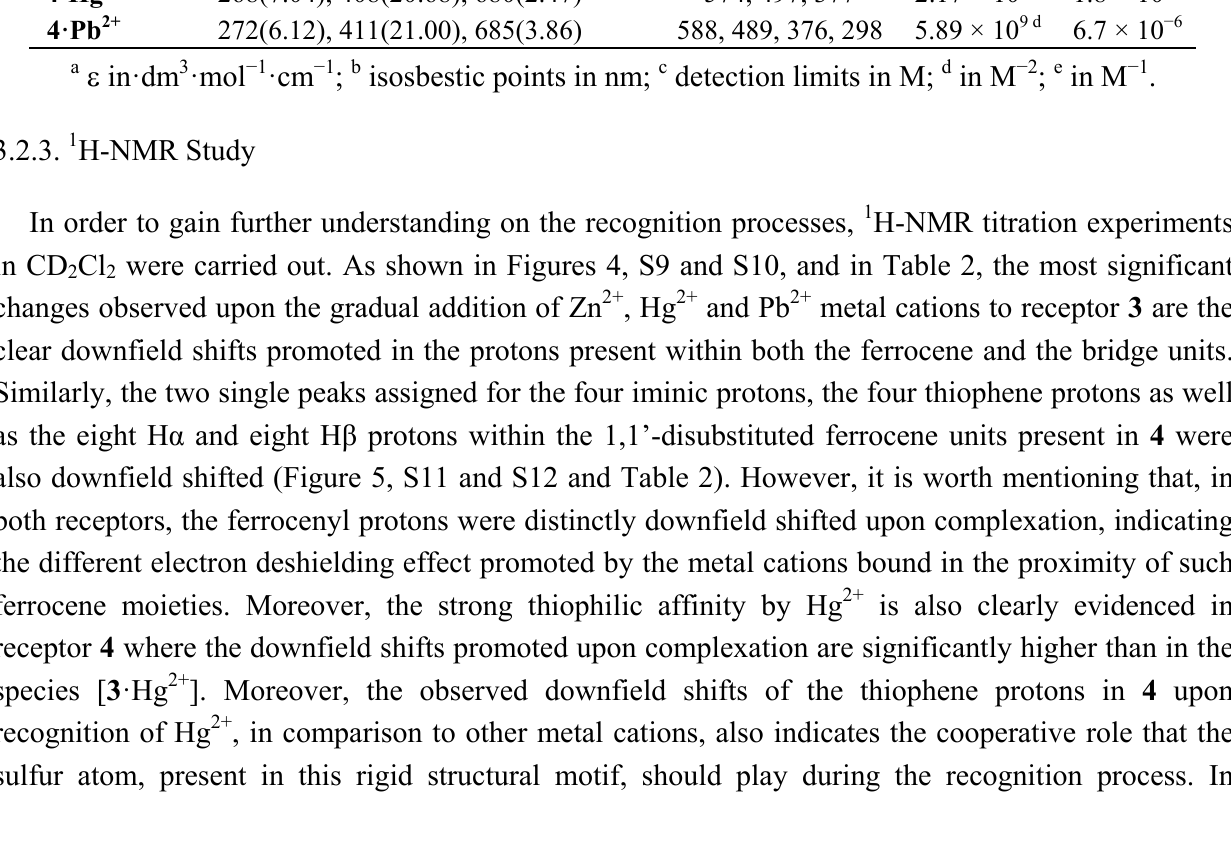
Table 1. Characteristic UV-Vis data for the receptors 3 and 4 and their metal complexes.